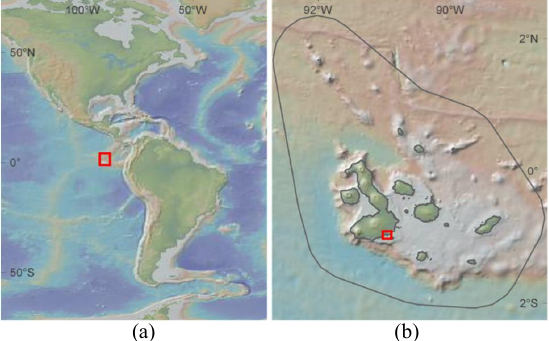
Figure 1 Galapagos Islands. (a) In the American Continent context, and (b) Puerto Villamil, Isabela Island